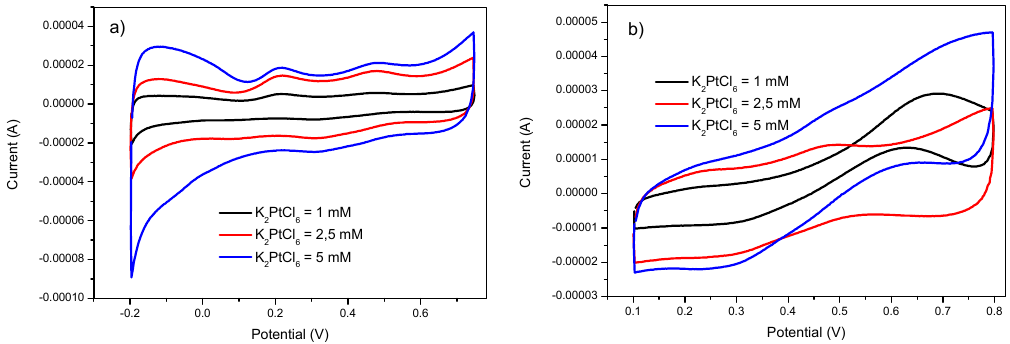
Figure 7. Cyclic voltammetry in ( a ) 0.5 M H 2 SO 4 and in ( b ) 2 M methanol +0.5 M H 2 SO 4 of GC/PANI(CV)/PtNPs electrodes obtained at various K 2 PtCl 6 concentrations (1, 2.5, and 5 mM).